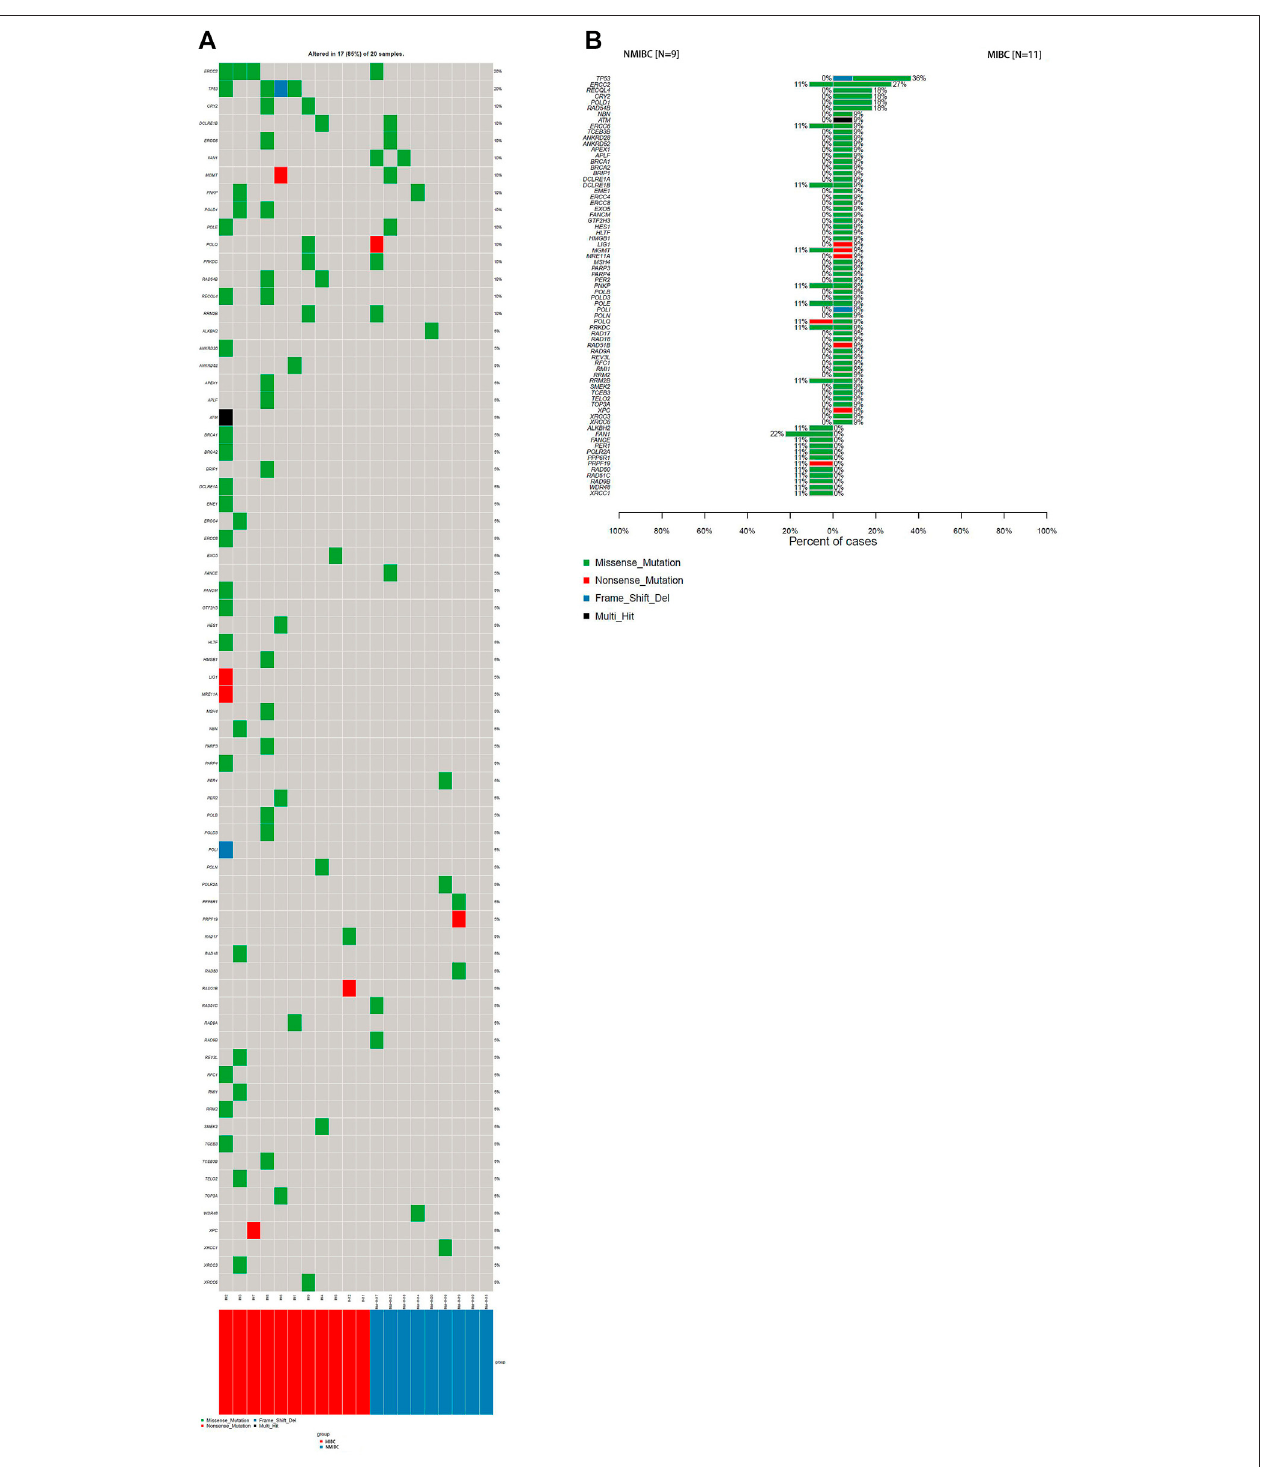
FIGURE 3 | The DDR gene mutation landscape of bladder cancer samples. (A) WES analysis of the DDR mutated genes in 20 bladder cancer samples; (B) Percentages of NMIBC and MIBC cases with DDR gene mutations assayed by WES. WES: whole exome sequencing; DDR: DNA-damage repair; NMIBC: non-muscle invasive bladder cancer; MIBC: muscle-invasive bladder cancer; WES: whole exome sequencing.